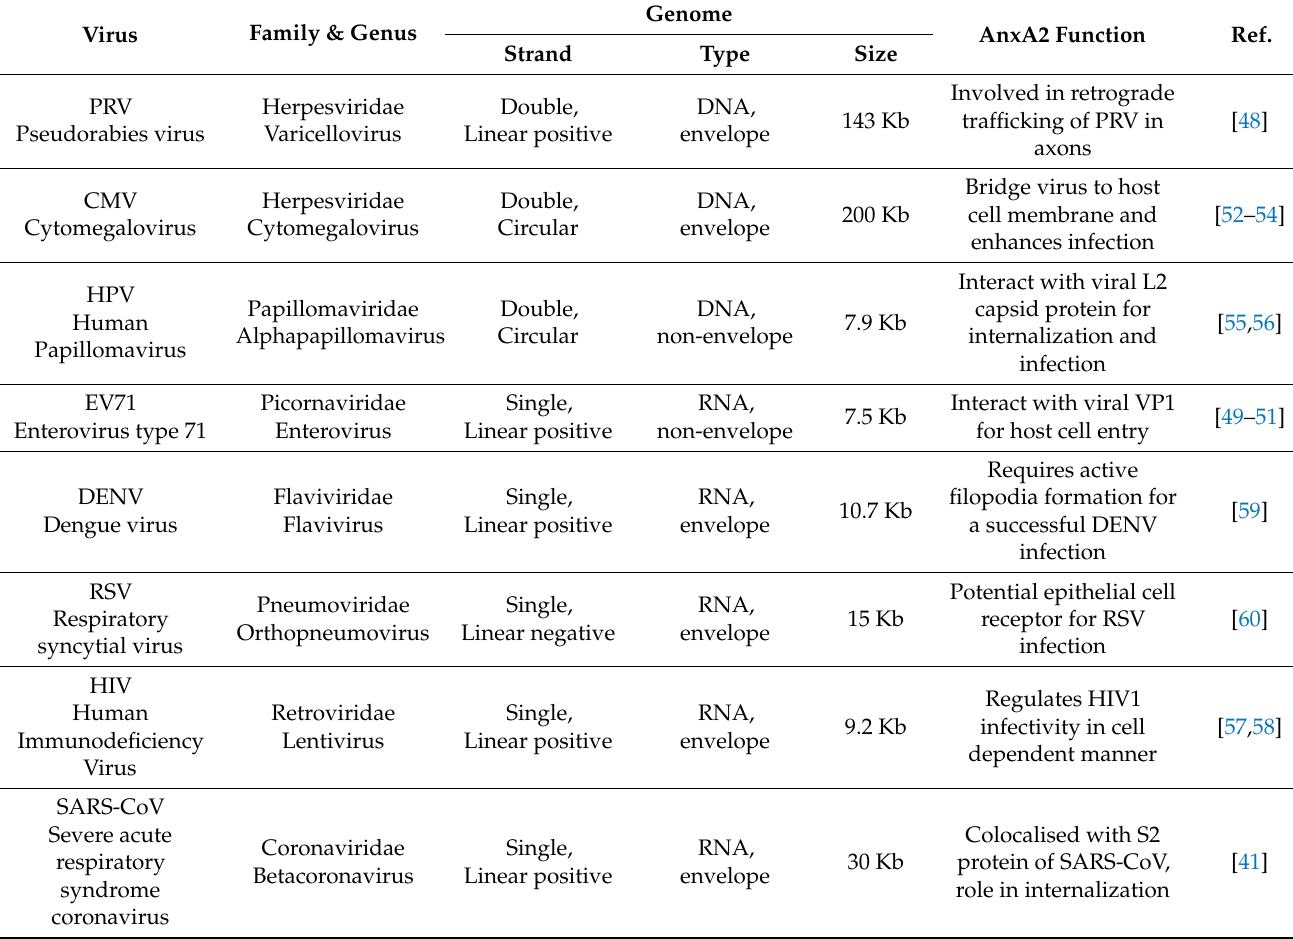
Table 1. The viruses interacting with AnxA2 for cell attachment, entry and internalization.